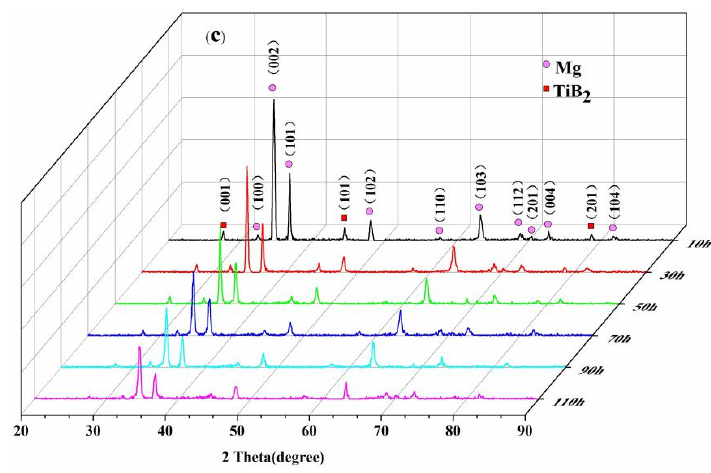
Figure 7. XRD patterns of AZ31/TiB 2 composite powders with different TiB 2 additions after milling for different times: ( a ) 2.5 wt %, ( b ) 5 wt %, and ( c ) 10 wt %.